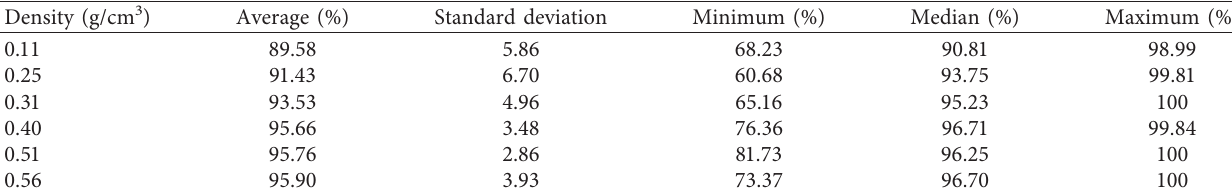
Figure 5: Section cell roundness distribution of polyurethane polymer samples of various densities. Table 2: Summary of the statistical parameters of the section cell